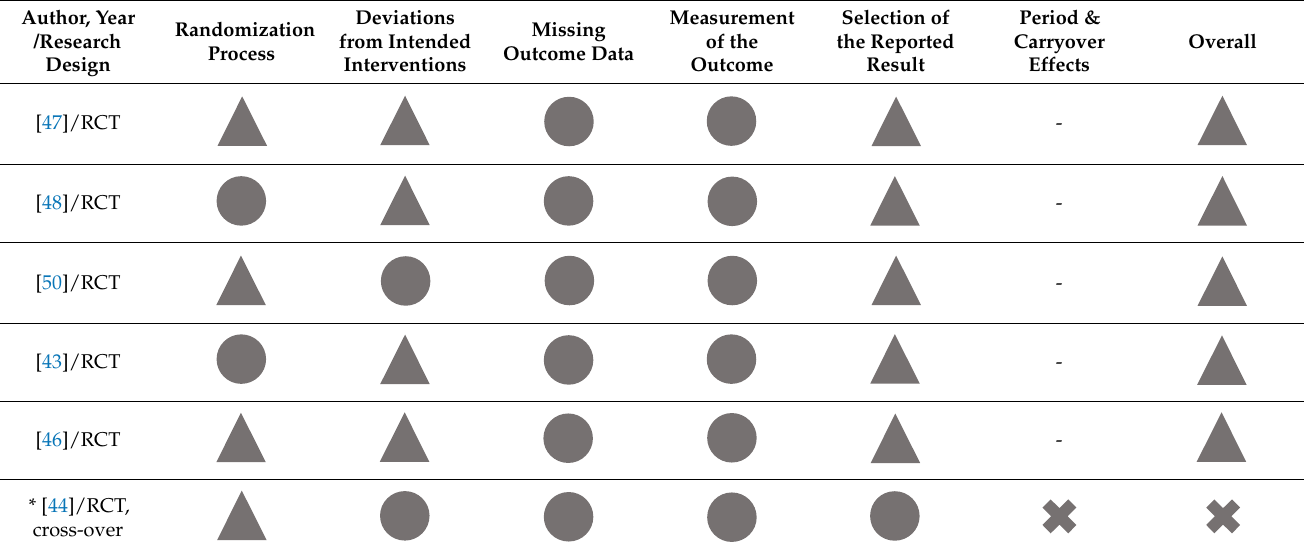
Table 6 The risk of bias assessment for the randomized clinical trials using the ROB 2 criteria.